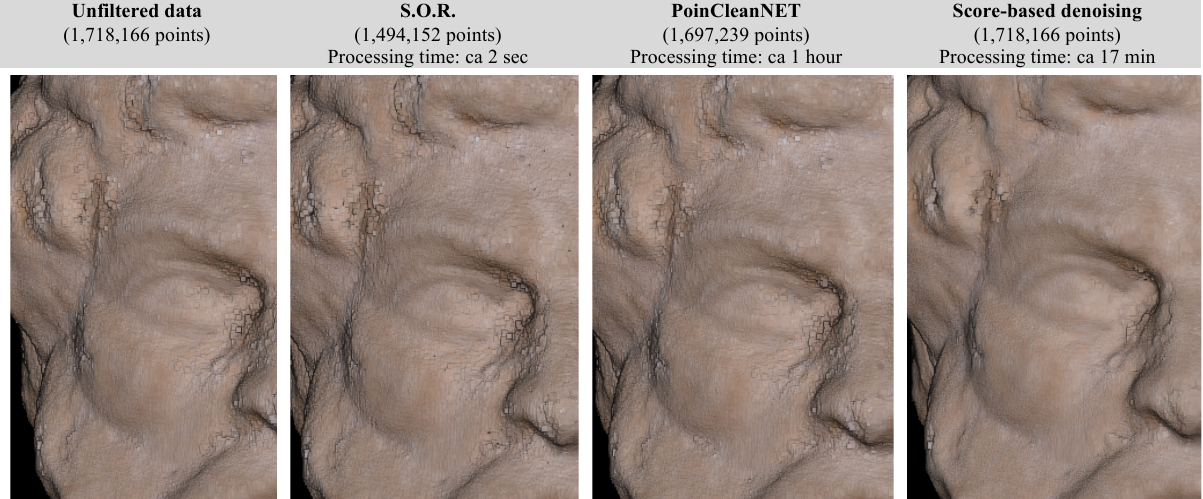
Figure 12: A visual comparison of denoising methods tested on the dense point cloud of the Moses statue. It should be noted that this method is not removing any 3D point from the cloud, it is only moving them based on a neural